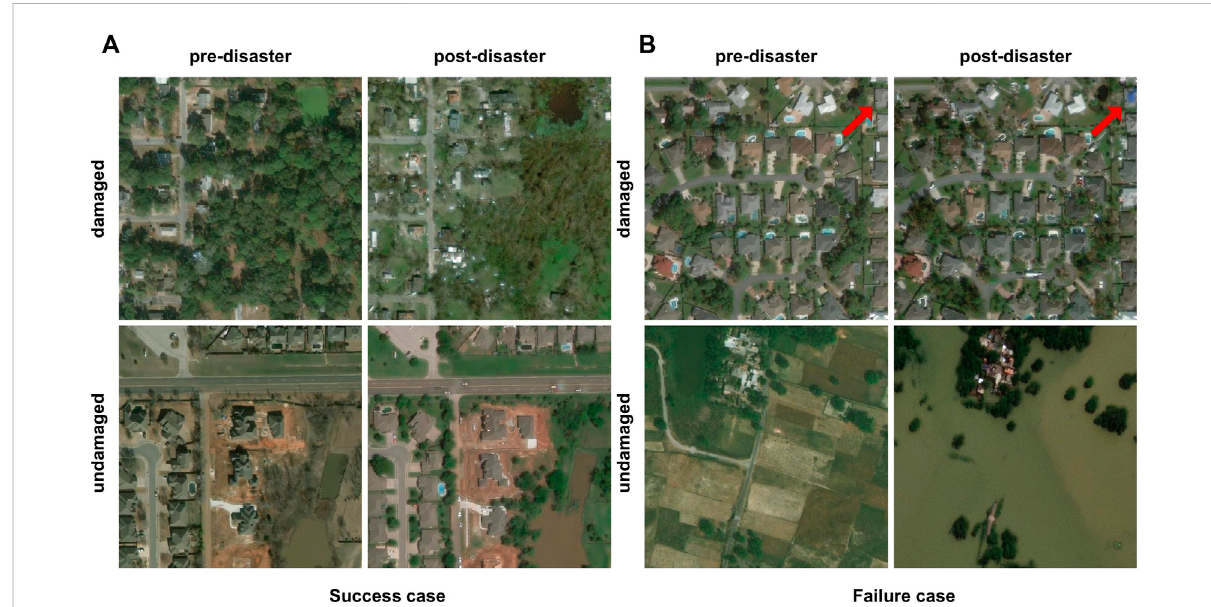
FIGURE 5 The Success (A) and failure (B) cases of the suggested model on the xBD dataset. Left-label shows the ground-truth label of each image pair. Our model successfully detects the damage when the image contains representative damage features. The model fails to report damage when the imageincludesmoreno-damagebuildings.ThefailurescenarioontheundamagedlabelalsoshowsthexBDdataset ’ slimitation,whichonlylooksat building damages.